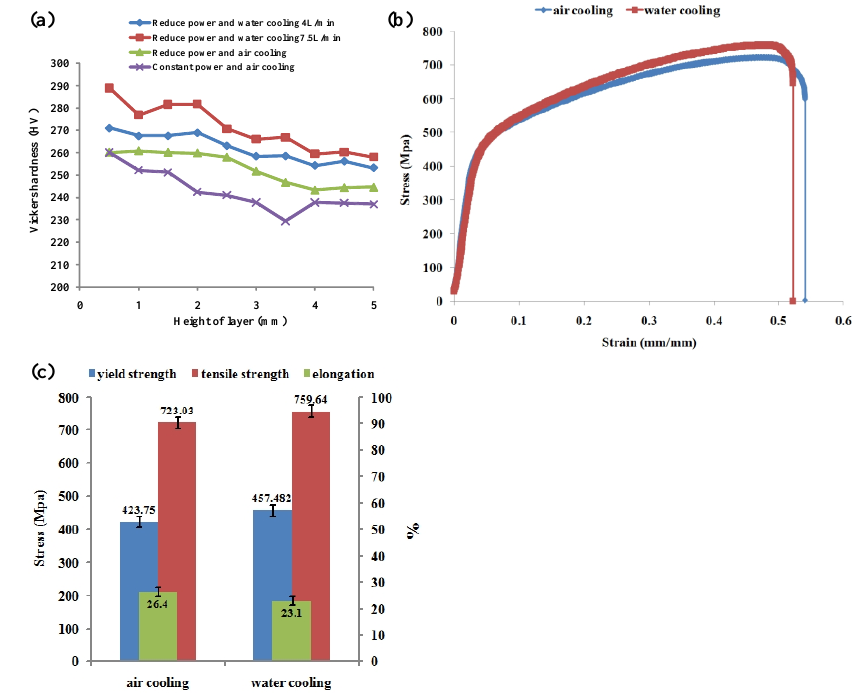
Figure 21. Analysis of the effect of cooling on formability: ( a ) the Vickers hardness trend of the cladding layer under the four conditions, ( b ) the tensile curve, ( c ) the yield strength, tensile strength and elongation of the tensile samples.